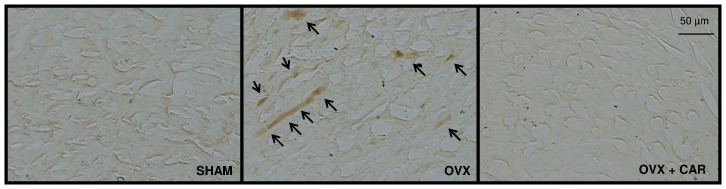
Immunohistochemistry of p22phox in papillary muscle.Photomicrographs of short-axis cross-sections of papillary muscle from representative animals in the SHAM, OVX, OVX+CAR groups that were immunostained for p22phox with DAB (brown). Regions of interest are shown at higher magnification (200X). Strong p22phox immunoreactivity was noted in the OVX group. In carvedilol rats, p22phox immunoreactivity was dramatically decreased in the papillary muscle.